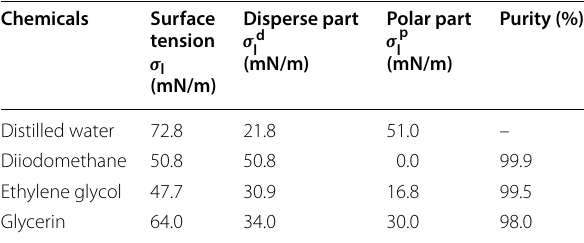
Table 2 Surface tension and its polar and disperse